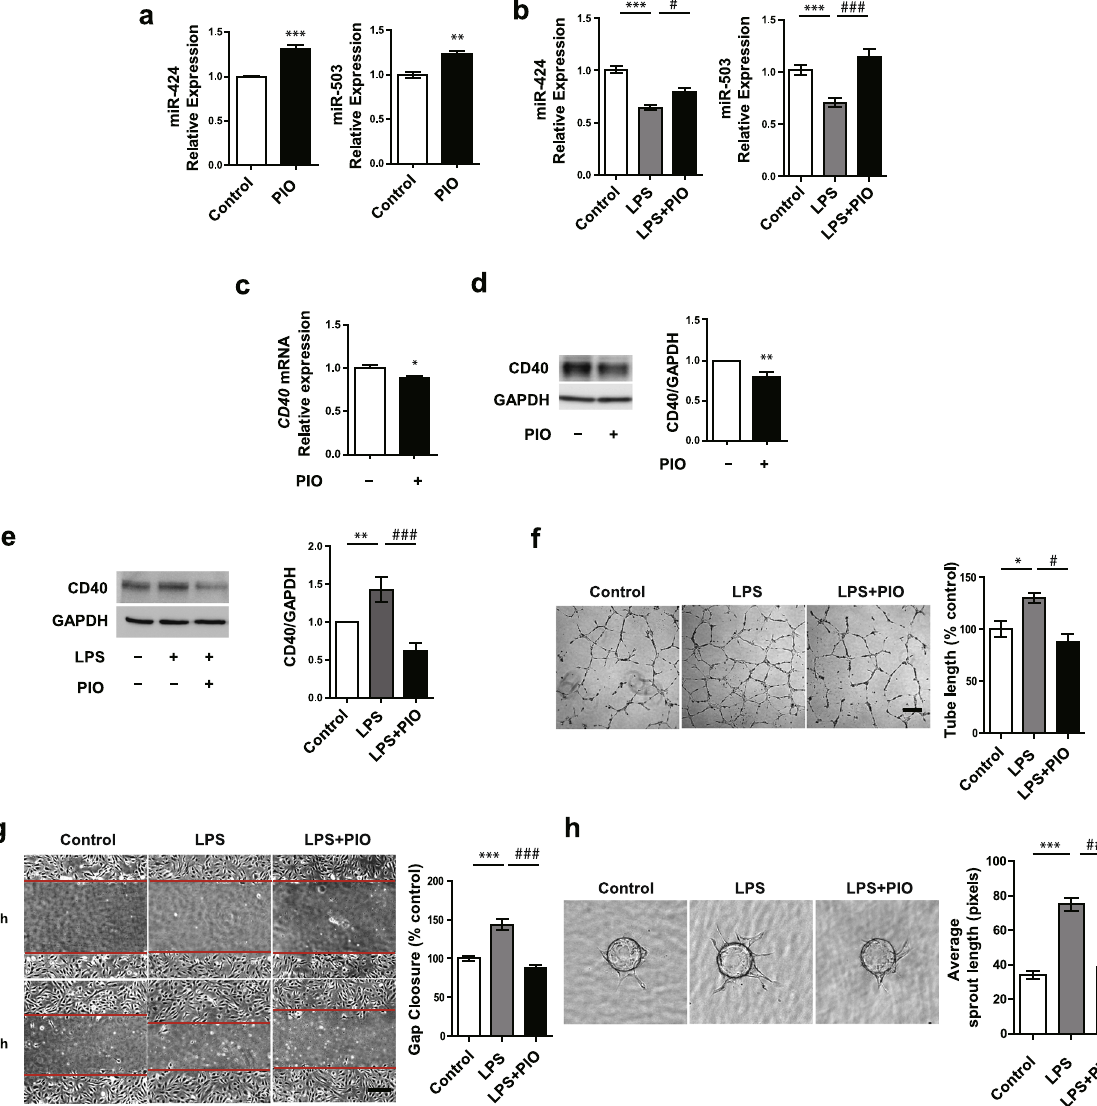
Figure 4. Pioglitazone ameliorates LPS-induced angiogenesis by regulation of CD40 expression. ( a ) Mature miR-424 and miR-503 expression in response to pioglitazone (10 μ M) for 24 h. PIO, Pioglitazone. ( b ) Mature miR-424 and miR-503 expression in response to LPS (1 μ g/ml) with or without concurrent stimulation with pioglitazone (10 μ M) for 24 h. ( c , d ) CD40 mRNA and protein expression in response to LPS (1 μ g/ml) with or without pioglitazone (10 μ M) for 24 h. ( e ) CD40 protein expression in response to LPS (1 μ g/ml) with or without pioglitazone (10 μ M). ( f , g ) Tube formation and cell migration assay response to LPS (1 μ g/ml) with or without concurrent stimulation with pioglitazone (10 μ M) at 9 h. ( h ) Sprouting assay using HUVEC coated beads in response to LPS (1ug/ml) with or without pioglitazone (10 μ M). * P < 0.05, ** P < 0.01, *** P < 0.001 compared to controls. # P < 0.05, ### P < 0.001 compared to LPS. Error bars, s.e.m. Images are representative of three independent experiments. Cropped gel images are shown; uncut gels are included in the Supplementary